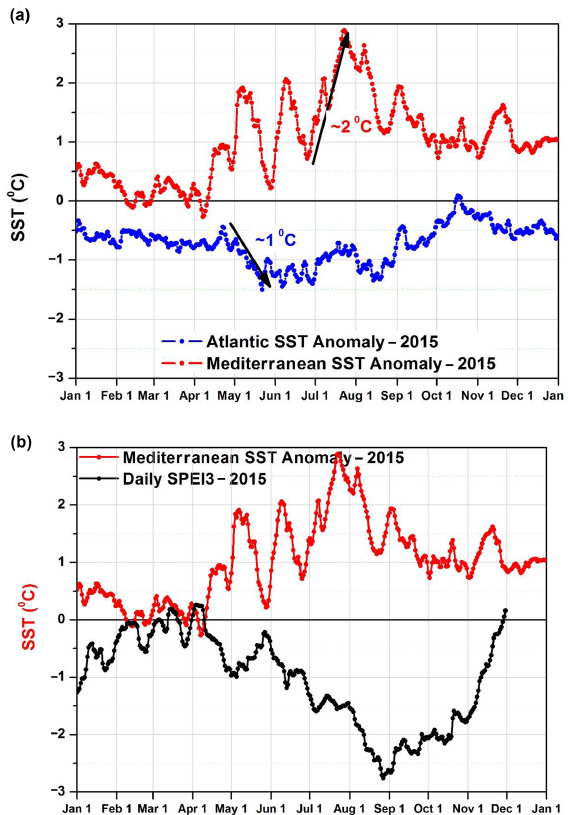
Figure 5. (a) 2015 Daily SST anomalies computed over the central Atlantic Ocean (blue line) and the Mediterranean Sea (red line); (b) 2015 Daily SPEI3 computed over the eastern part of Europe (black line) and the Mediterranean Sea (red line). The daily SST indices are based on the OISST dataset (Reynolds at al.,